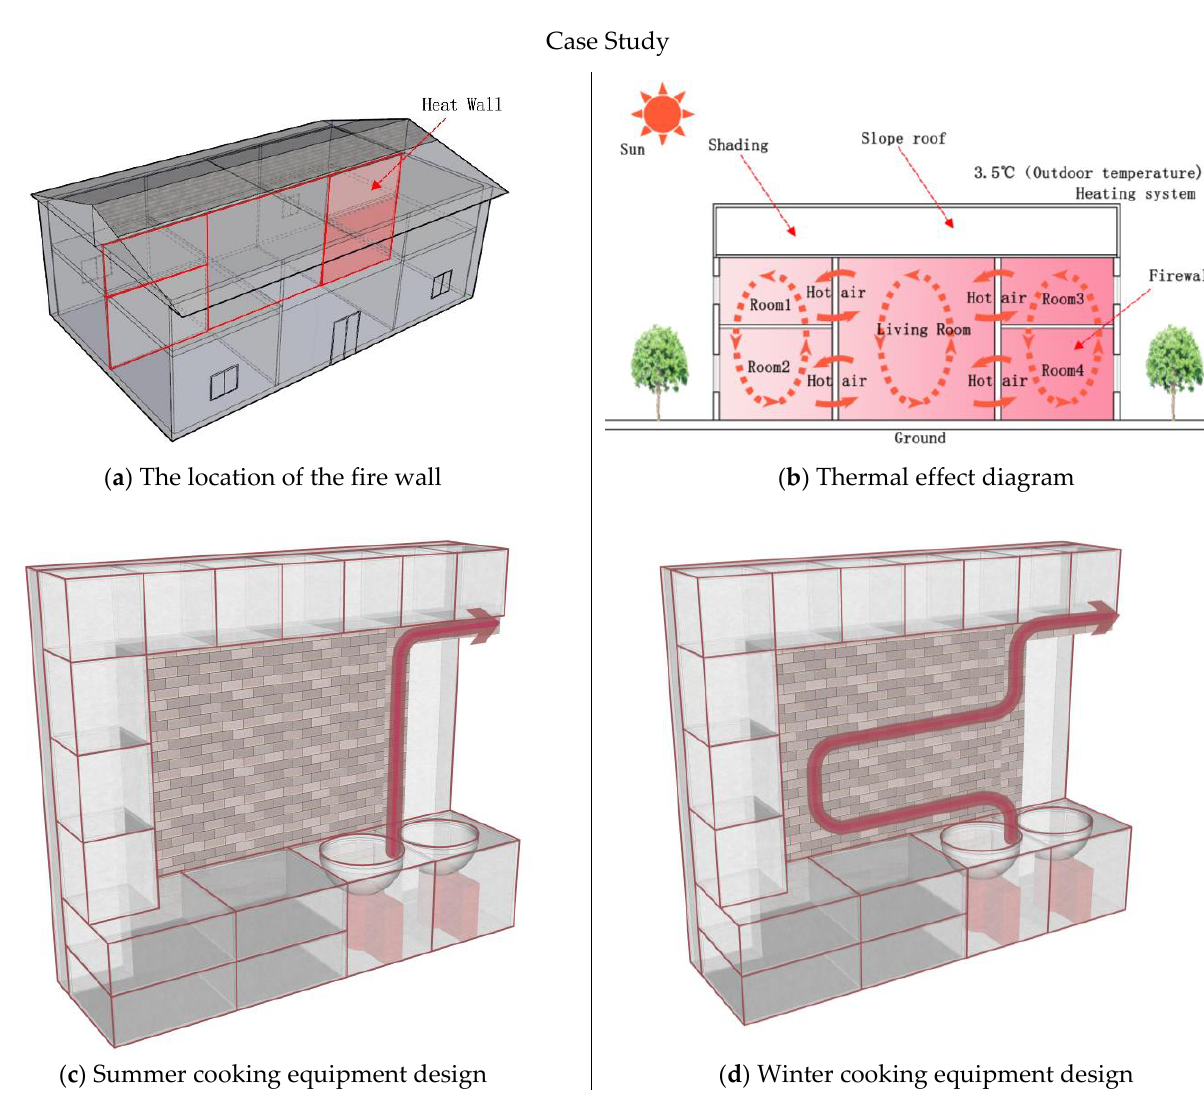
Figure 3. ( a ) The location of the fire wall; ( b ) Thermal effect diagram; ( c ) Summer cooking equipment design; ( d ) Winter cooking equipment design.